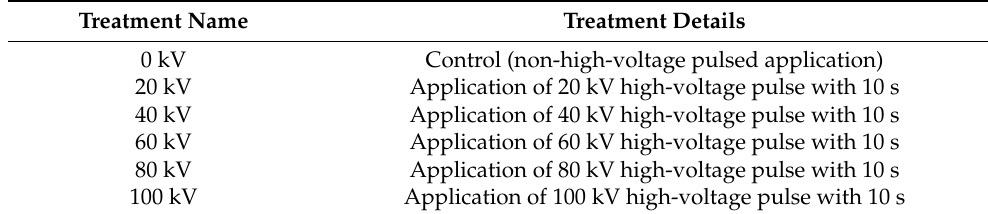
Table 1. Treatment details of this